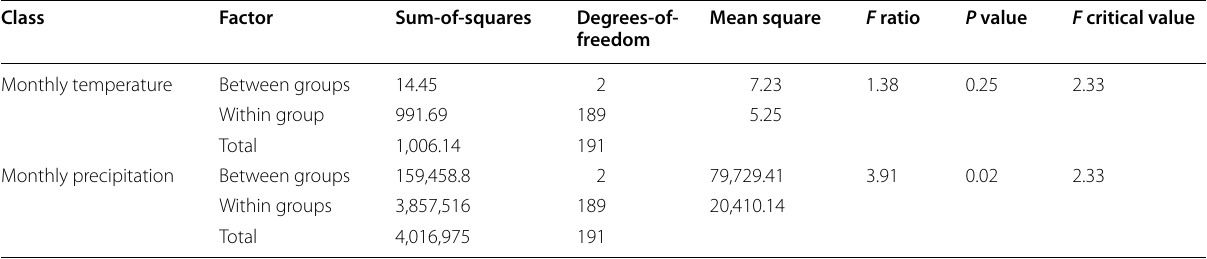
Mean square F ratio P value F critical value freedom